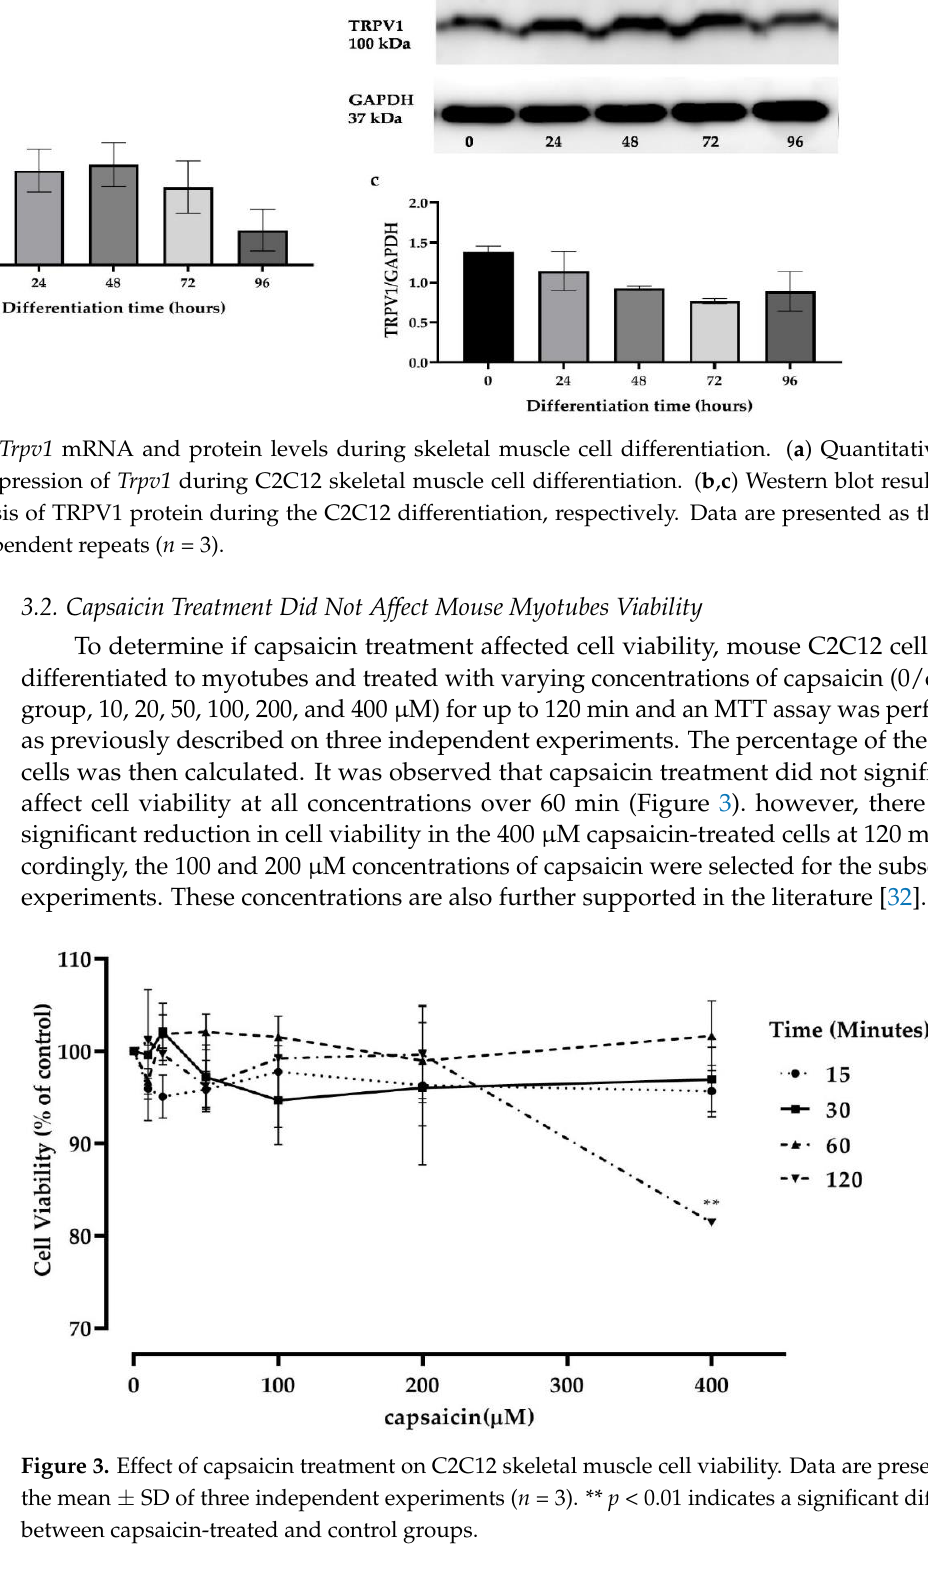
Figure 1. Gene expression of Myog, Tnni1 , Tnni2 , Abca1, and Fabp3 . ( a – e ). Quantitative real-time PCR mRNA expression of Myog , Tnni1 , Tnni2 , Abca1 , and Fabp3 respectively during the differentiation of C2C12 skeletal muscle cells. Data are presented as the mean ± SD of three independent repeats ( n = 3). * p < 0.05; ** p < 0.01; *** p < 0.001; **** p < 0.0001 indicate a significant difference between differentiated and the control groups.